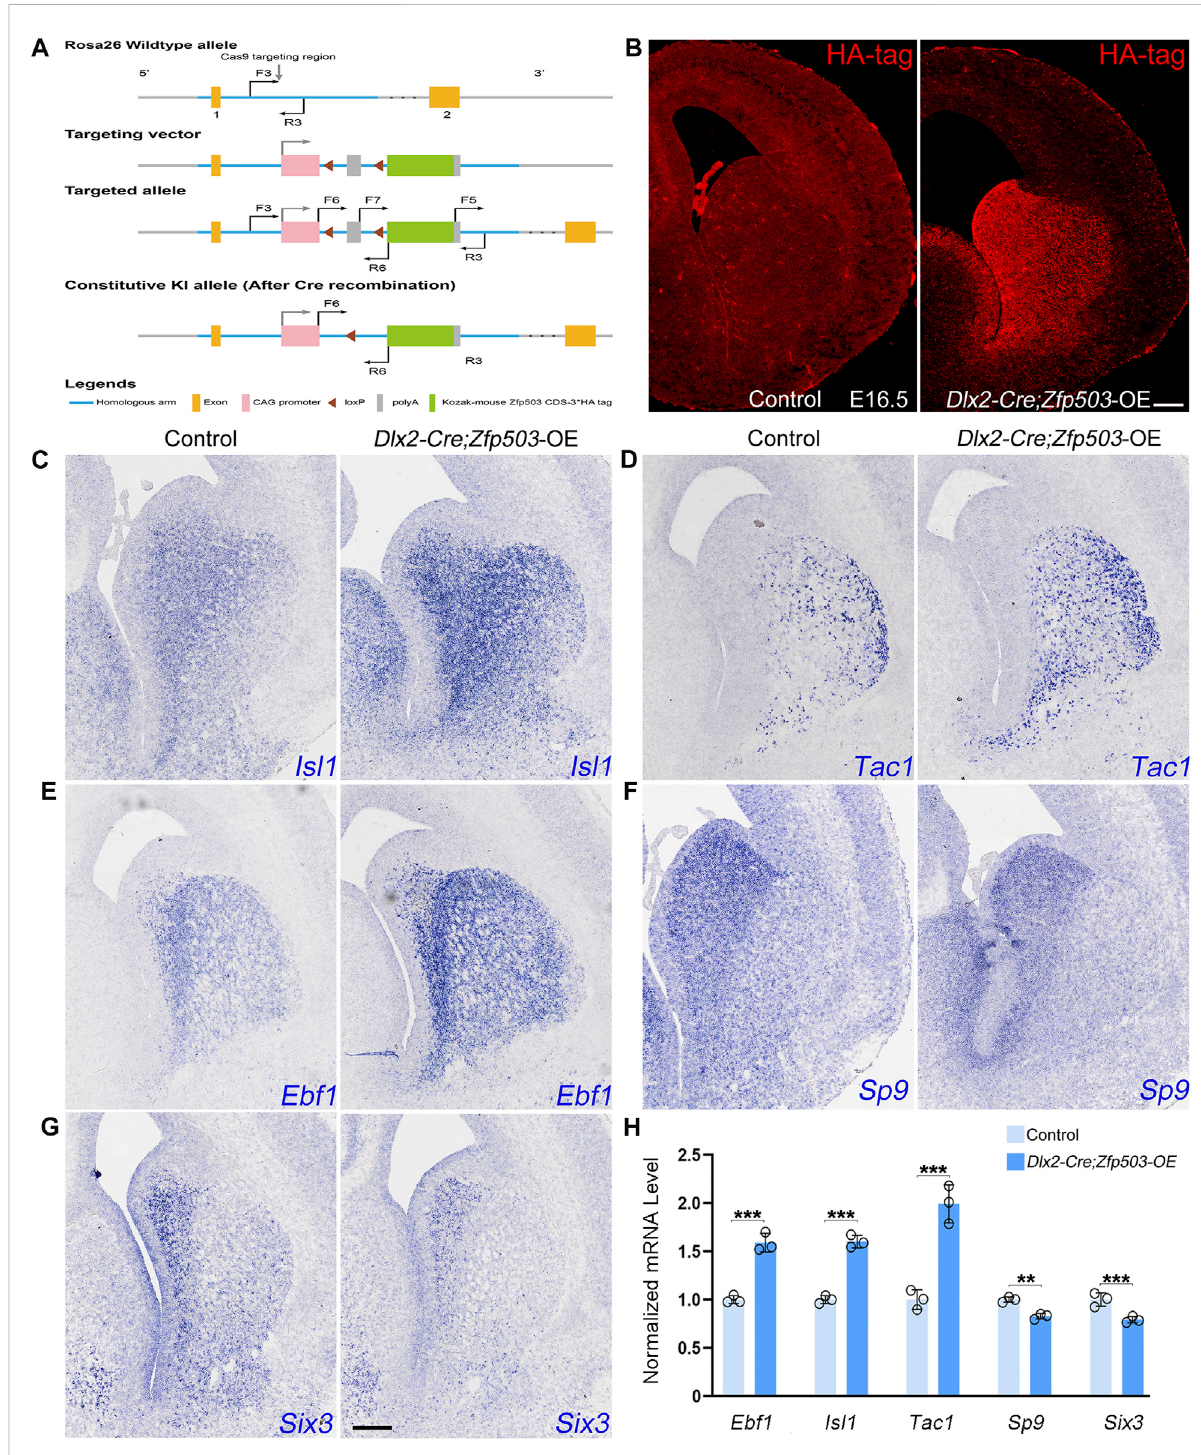
The D1 MSN identity is enhanced and the D2 MSN identity is compromised in Zfp503 -overexpressing mice. (A) Generation of the Zfp503 overexpression allele. A CAG promoter followed by a Zfp503 CDS and three HA-tag sequences was inserted into the Rosa-26 site with the CRISPR/ Cas9 strategy. (B) HA-tag was expressed in the septum, striatum and cortical interneurons, which is consistent with the Dlx2 expression in the forebrains. (C – E) The expression of Isl1 , Tac1, and Ebf1, which are speci fi cally expressed in D1 MSNs, was increased in Dlx2-Cre; Zfp503-OE miceatE16.5comparedtocontrols. (F – G) TheexpressionoftheTFs Sp9 and Six3 wasreducedin Dlx2-Cre;Zfp503-OE micecompared tocontrols. (H) Histogramshows quanti fi cationdata oftheabove markers inthe Dlx2-Cre; Zfp503-OE, and control mice atE16.5(unpairedtwo-tailedStudent ’